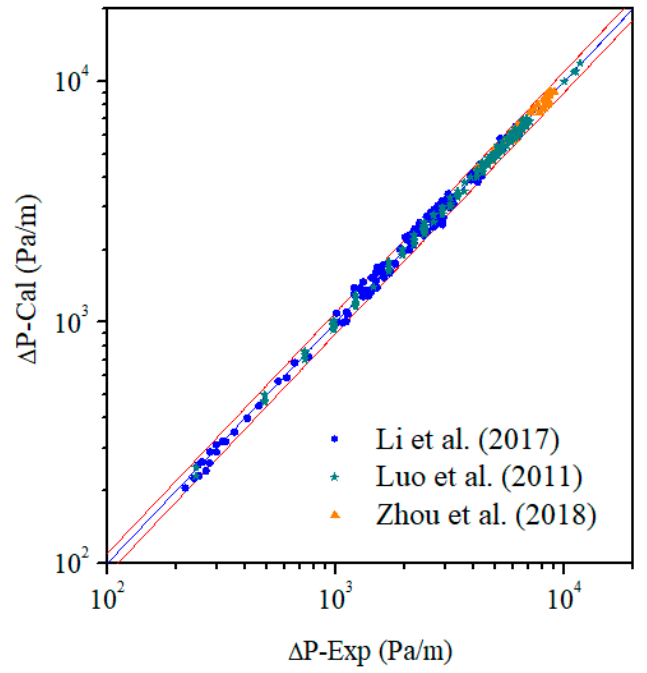
Figure 8. Comparison of predicted pressure drop with experimental values of dataset reported by Li et al. [2], Luo et al. [48] and Zhou et al. [49]. Determination coefficient of ( R 2 ) as well as mean absolute percent error (AAPE) were calculated to evaluate the optimal network performance. R 2 is defined as: